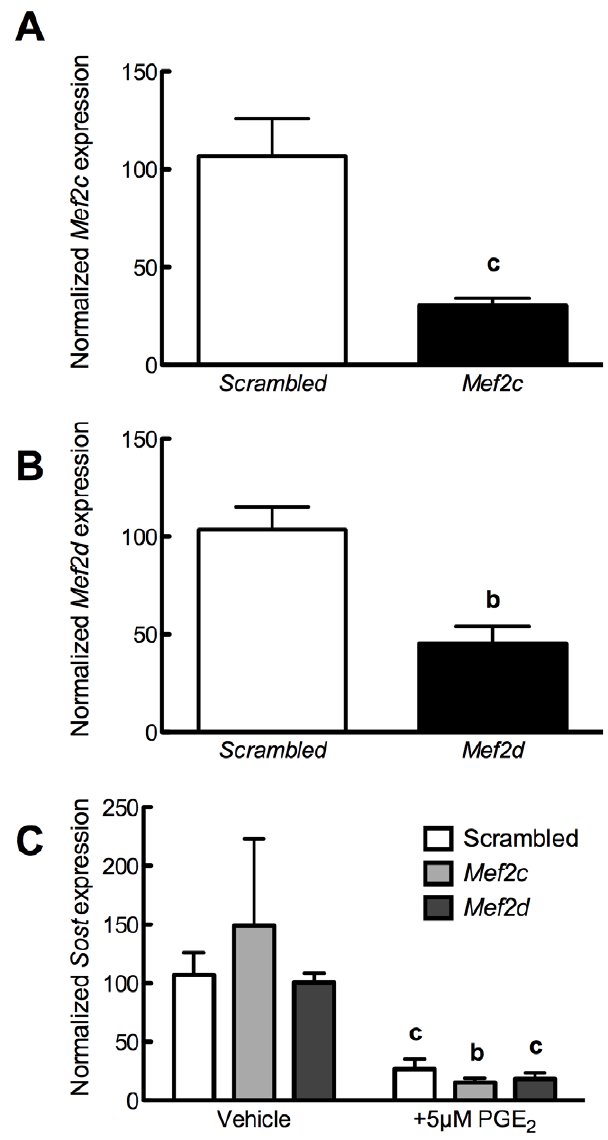
Figure 6. Reductions in MEF2 expression do not impair PGE 2 decrease of Sost . ( A ) UMR106.01 cells were cultured with 50 nM of scrambled or Ptger4 siRNA for 48 hours, after which Mef2c expression was examined by qPCR. n=4 samples. Compared to scrambled control, c indicates p , 0.001. ( B ) UMR106.01 cells were cultured with 50 nM of scrambled or Ptger4 siRNA for 48 hours, after which Mef2d expression was examined by qPCR. n=4 samples. Compared to scrambled control, c indicates p , 0.01. ( C ) UMR106.01 cells were cultured with 50 nM of scrambled, Mef2c , or Mef2d siRNA for 48 hours, then with 5 m M PGE 2 for 3 hours, after which time total RNA was collected and analyzed for Sost and Rpl32 . n=5 samples. Compared to target siRNA control, b indicates p , 0.01 and c indicates p ,